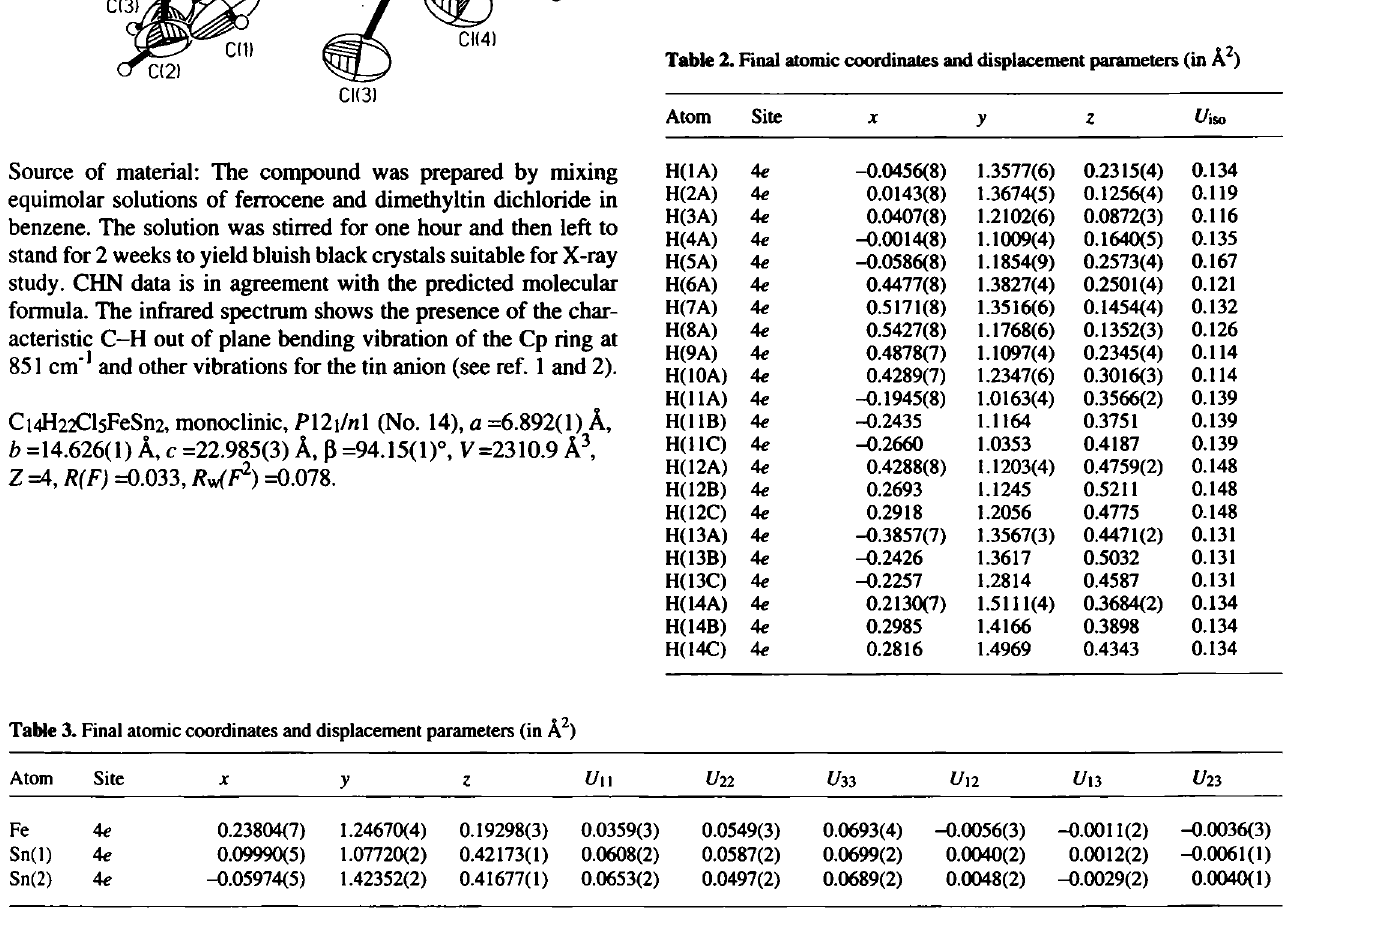
Table 3. Final atomic coordinates and displacement parameters (in